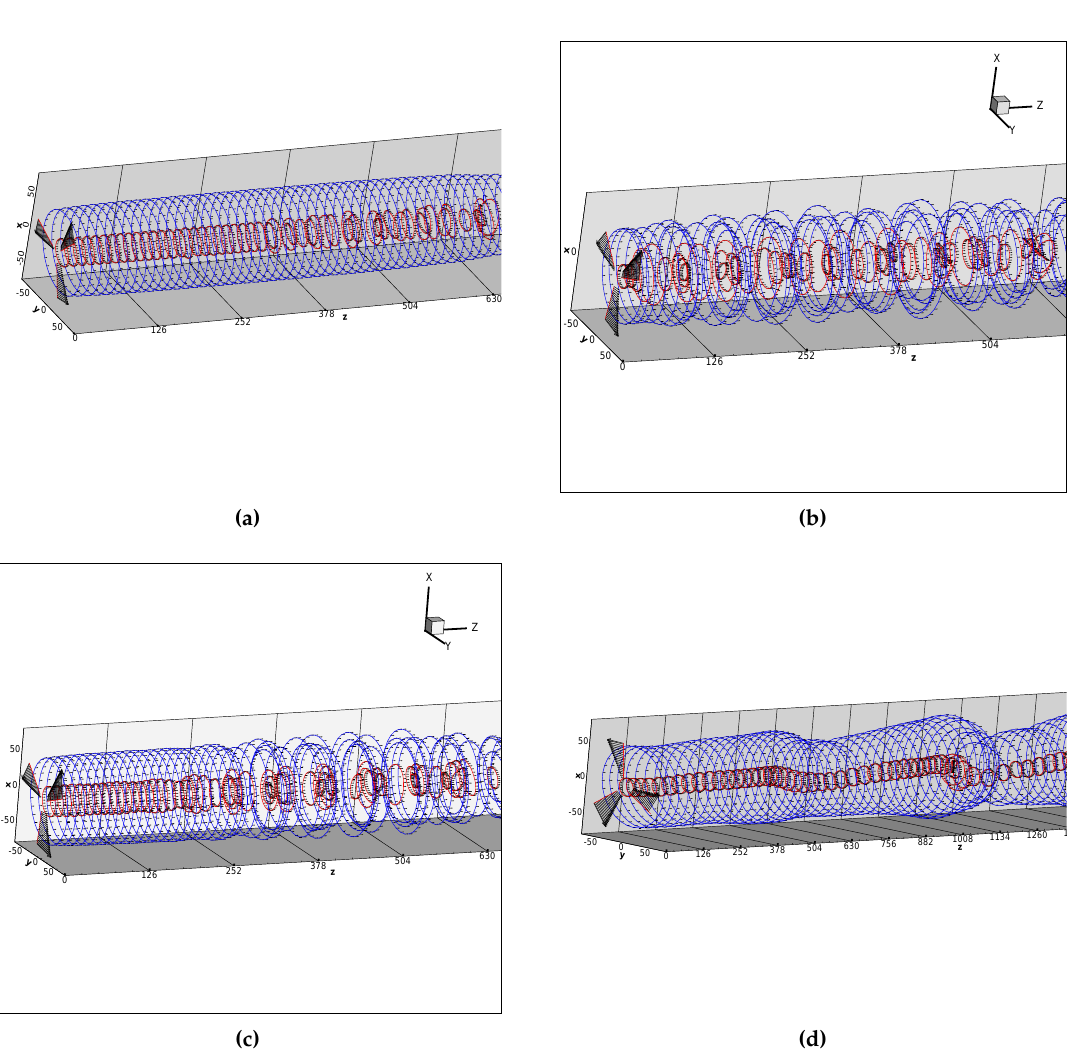
Figure 16. Wake structures of the NREL 5 MW turbine: ( a ) bottom fixed below-rated; ( b ) ITI barge below-rated; ( c ) OHS below-rated; and ( d ) OHS